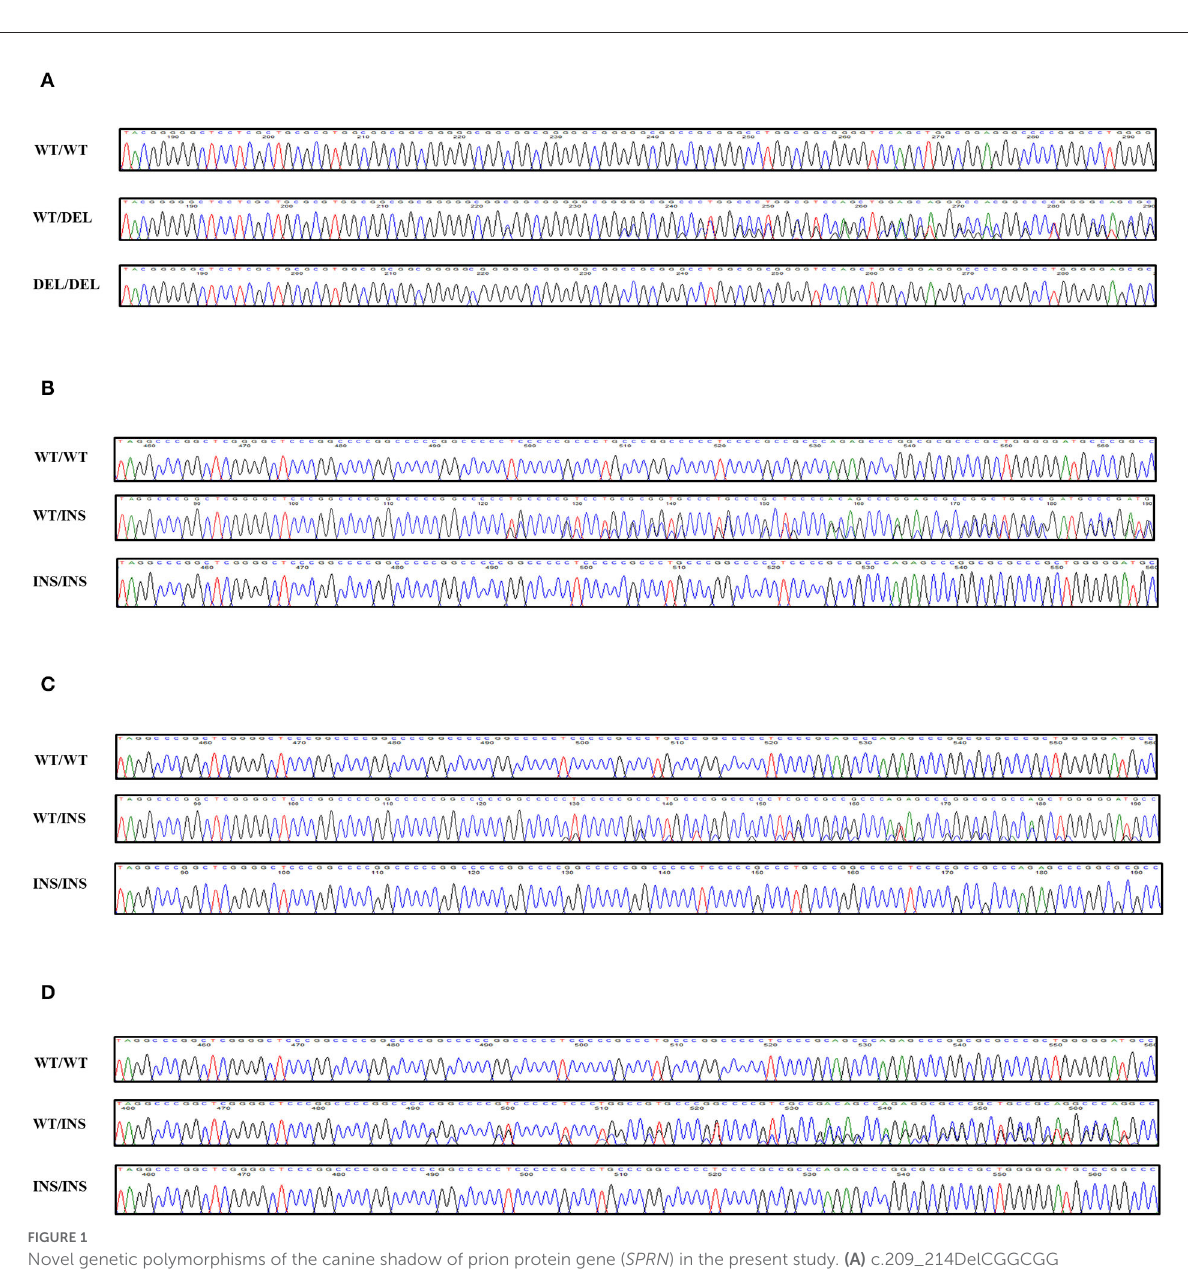
Multiple sequence